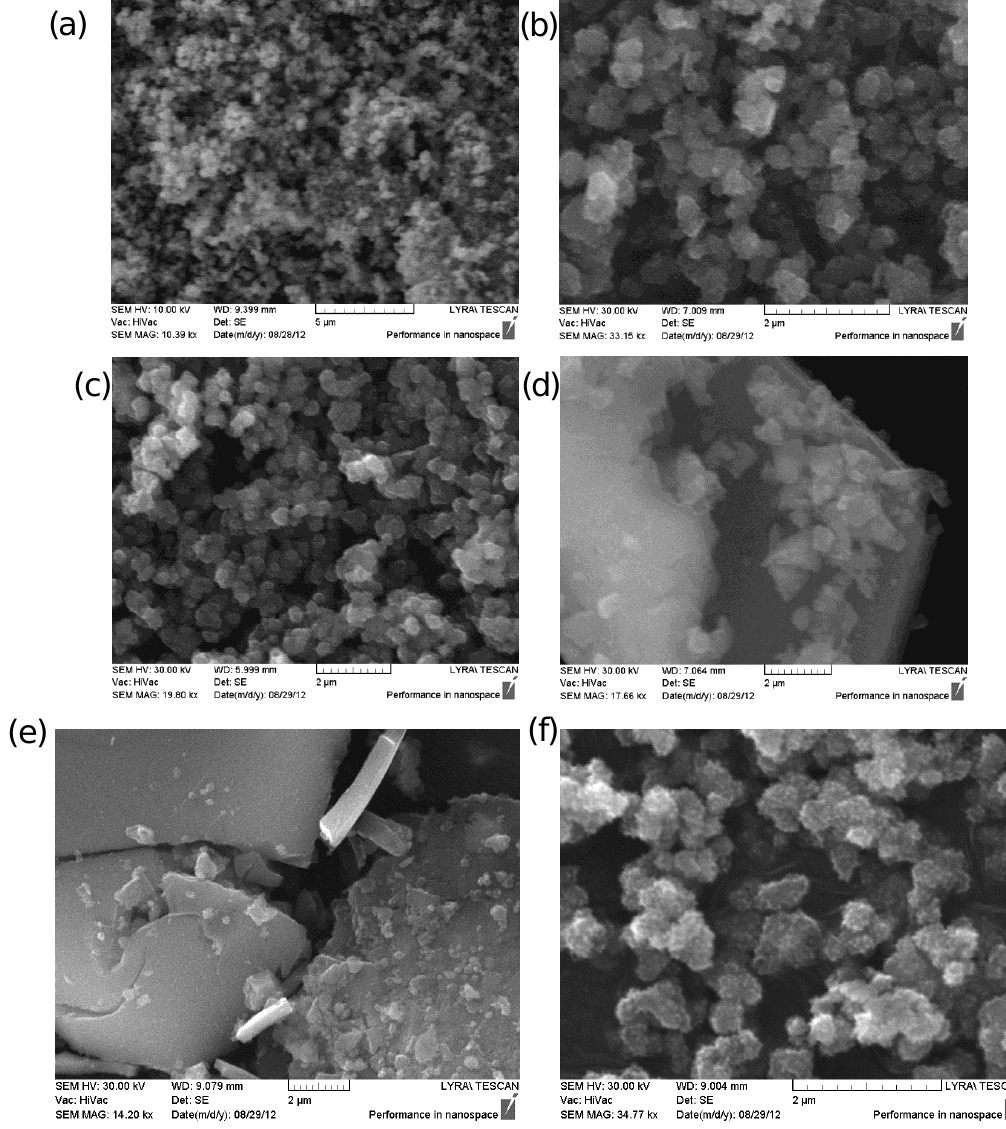
Figure 8. SEM images of the formed aggregates from TiO 2 particles at ≈ 1.37 M concentration of the precursor TiCl 4 (with respect to the aqueous phase) and 1 wt % surfactant Span 80 (with respect to the oil) in hexadecane. The emulsification was performed with Ultra Turrax. In cases ( a – c ) the initial emulsions were prepared at 20,500 rpm for 5 min and the emulsion mixing was made at ( a ) 8000 rpm, ( b ) 13,500 rpm, and ( c ) 20,500 rpm for 10 min. In cases ( d – f ) the initial emulsions were obtained at ( d ) 8000 rpm, ( e ) 13,500 rpm, and ( f ) 20,500 rpm and the mixing was made at 20,500 rpm for 10